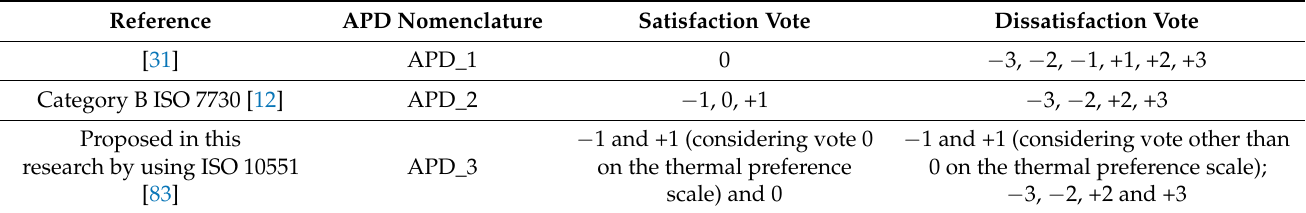
Table 4. Methods for calculating each